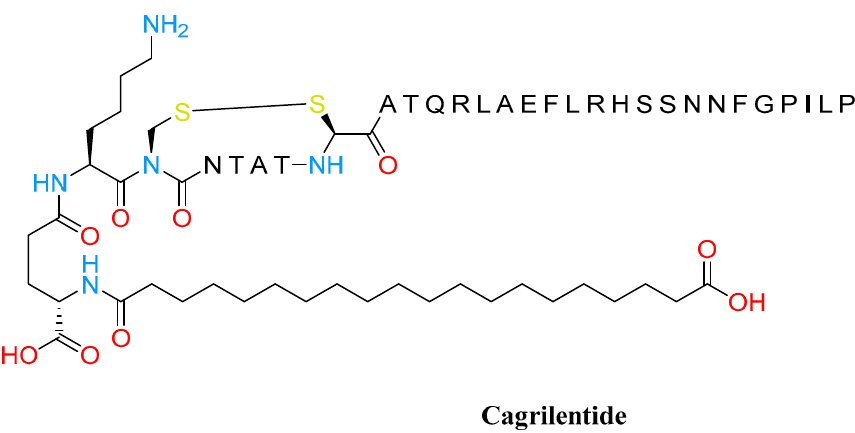
Figure 6. Cagrilentide structure.